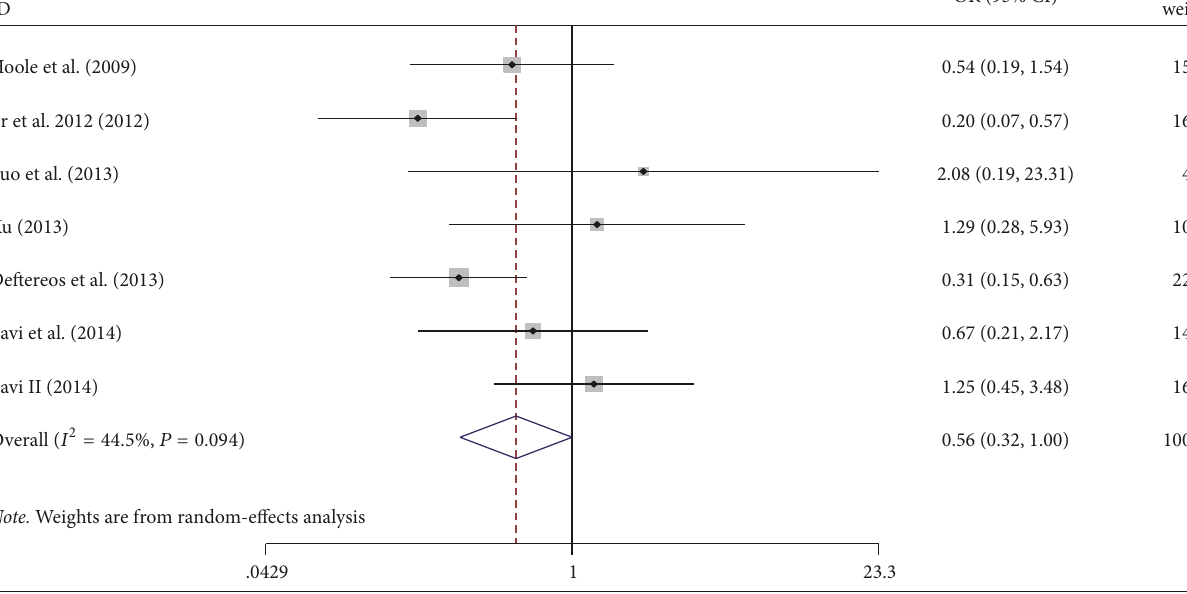
Figure 4: Forest plot for the incidence of acute kidney injury (AKI). RIPC: remote ischemic preconditioning; OR: odds